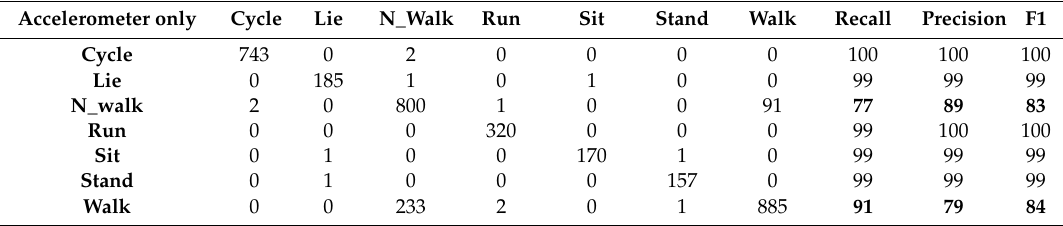
Table 6. Confusion matrix of a participant (with the highest GPS contribution) when using accelerometer data only (Scenario 2).